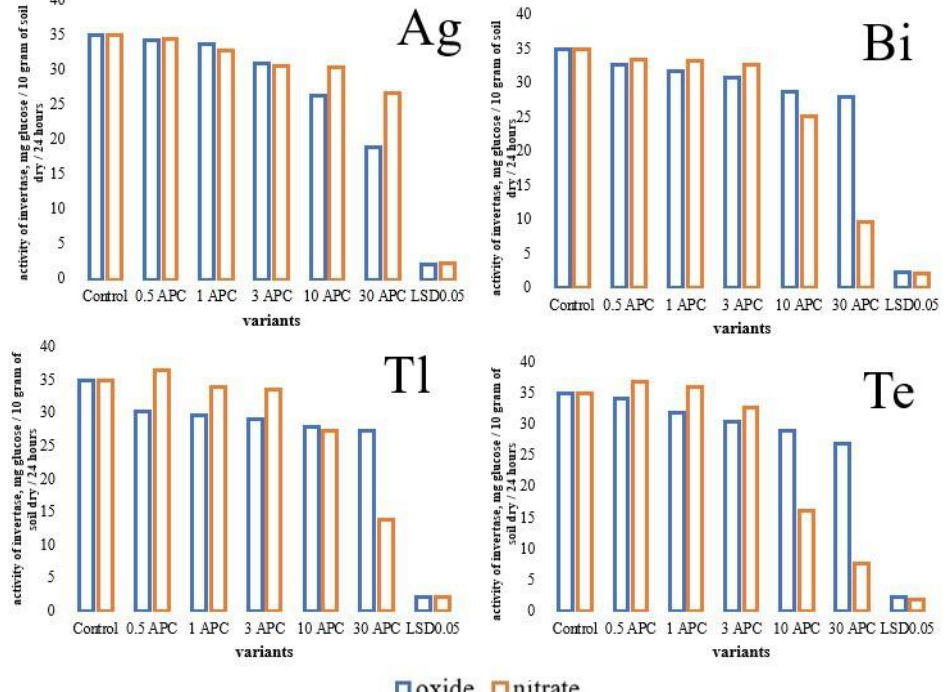
Figure 5. Changes in activity of invertase in haplic chernozem under pollution with oxides and ni- trates of Ag, Bi, Tl, and Te, mg glucose/10 g of soil dry/24 h.